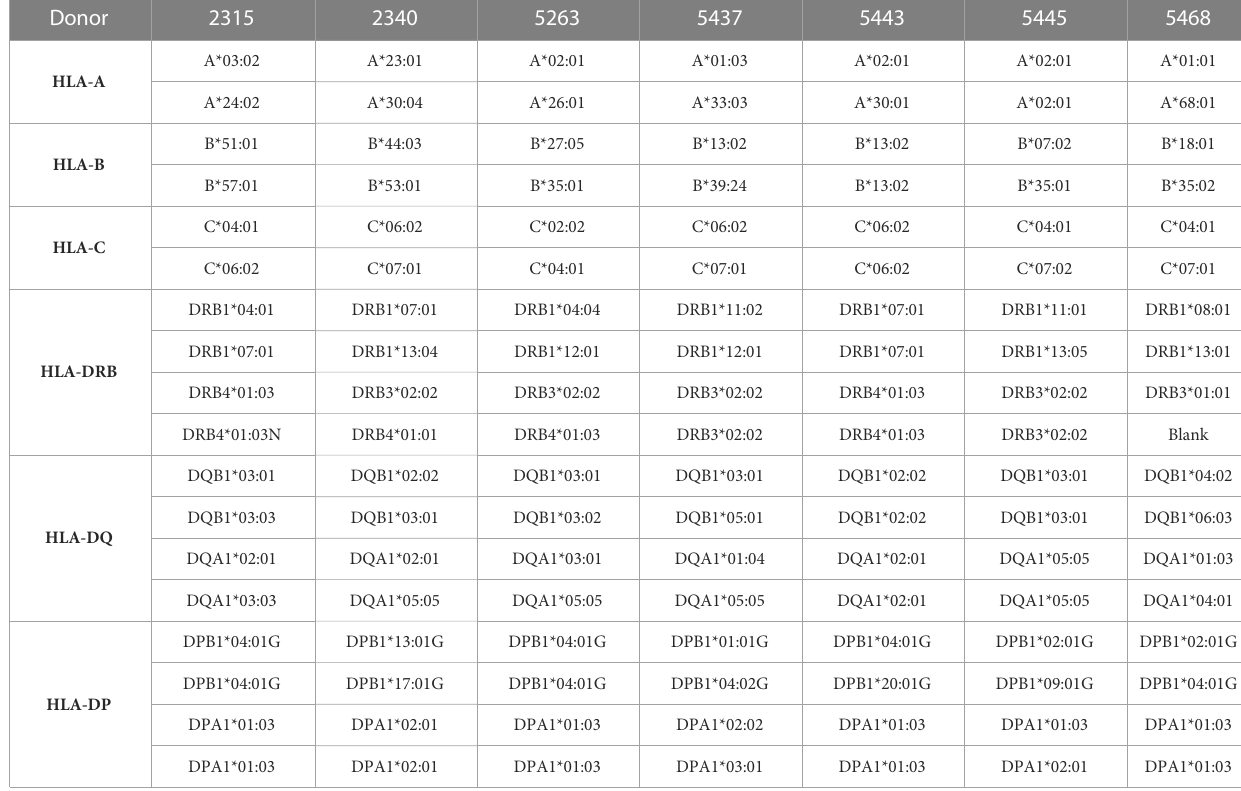
TABLE 1 HLA pro fi le for each